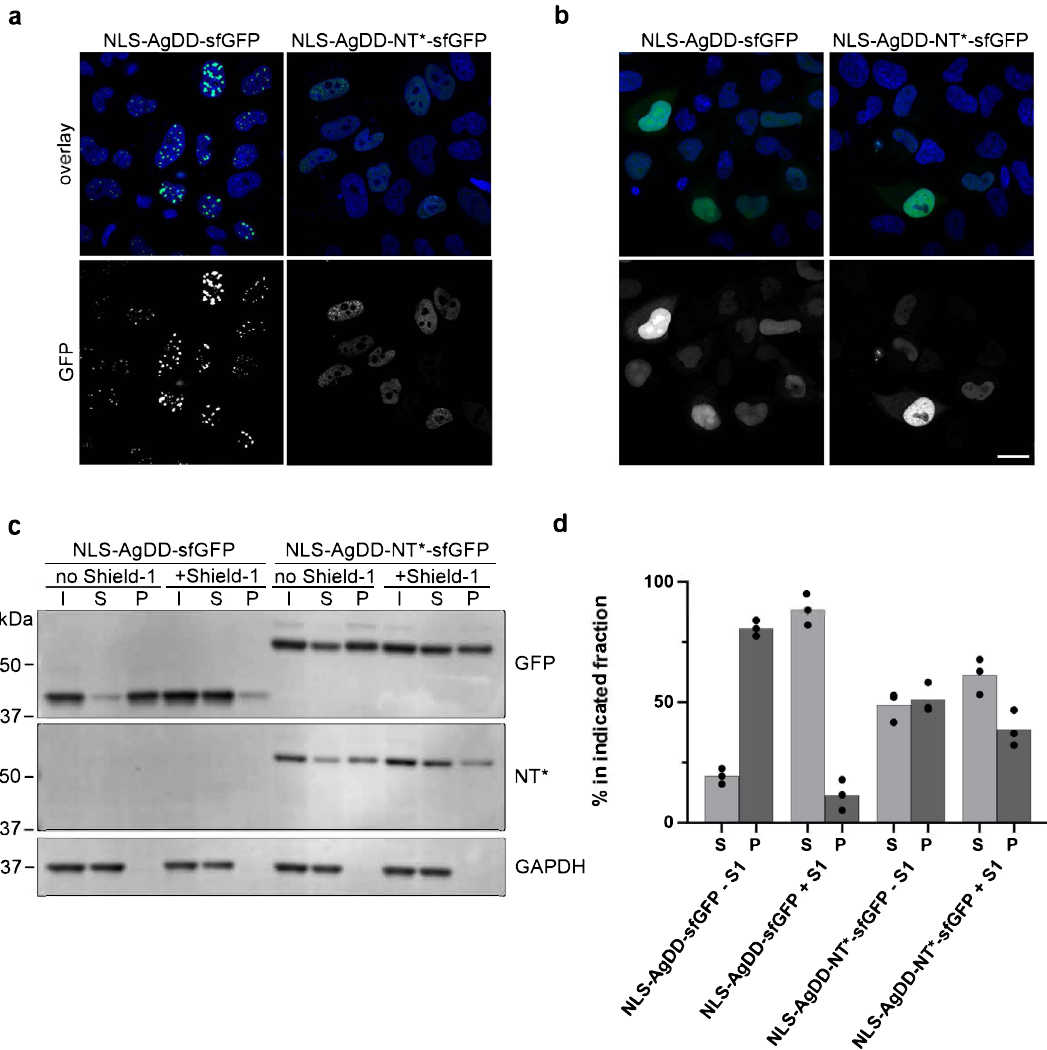
Fig. 3 NT* inhibits ligand-regulatable aggregation in the nucleus. a , b HeLa cells were transiently transfected with NLS-AgDD-sfGFP or NLS-AgDD-NT*- sfGFP and incubated in the absence ( a ) or presence ( b ) of 1 µ M Shield-1. Cells were fi xed 24 h after transfection with 4% PFA and counterstained with Hoechst. Scale bar is 20 µ m. c HeLa cells transiently transfected with NLS-AgDD-sfGFP or NLS-AgDD-NT*-sfGFP were incubated for 16 – 24 h in the absence of presence of 1 µ M Shield-1 and fractionated into Triton X-100 soluble (S) and Triton X-100 insoluble/SDS soluble (P) fractions. Input of whole cell lysates before fractionation are shown (I) Western blots were performed with antibodies directed against GFP, the NT*-tag and GAPDH. d Quanti fi cations of the relative distribution of the GFP band in the soluble and insoluble fractions from three independent experiments are